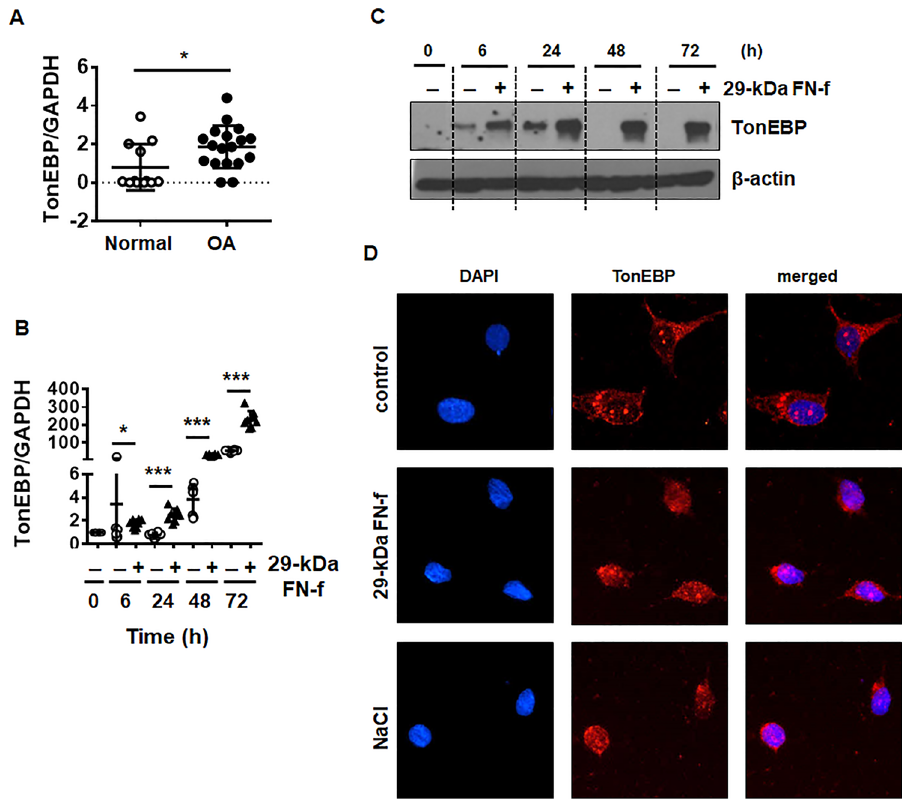
Figure 1. 29-kDa FN-f induces TonEBP expression in chondrocytes. ( A ) The level of TonEBP was elevated in OA compared with normal cartilage. The relative expression of TonEBP in normal and OA cartilage was determined via QuantiFast SYBR Green qRT-PCR. The expression level of TonEBP relative to that of glyceraldehyde 3-phosphate dehydrogenase (GAPDH), the internal control, is shown. Data represent the mean ± SD of duplicate data from six normal and nine OA donors. * P < 0.05 vs. normal cartilage. ( B ) mRNA and ( C ) protein levels of TonEBP were significantly increased in a time-dependent manner after treatment with 29-kDa FN-f. Chondrocytes were stimulated with 29-kDa FN-f (300 nM) for 6, 24, 48, and 72 h. PCR data are expressed as the mean ± SD of duplicate data from four independent donors. * P < 0.05 and *** P < 0.001 vs. untreated control. ( C ) The western blot shown is representative of blots from three independent donors. ( D ) Nuclear localization of TonEBP was induced by 29-kDa FN-f. After stimulation of primary chondrocytes